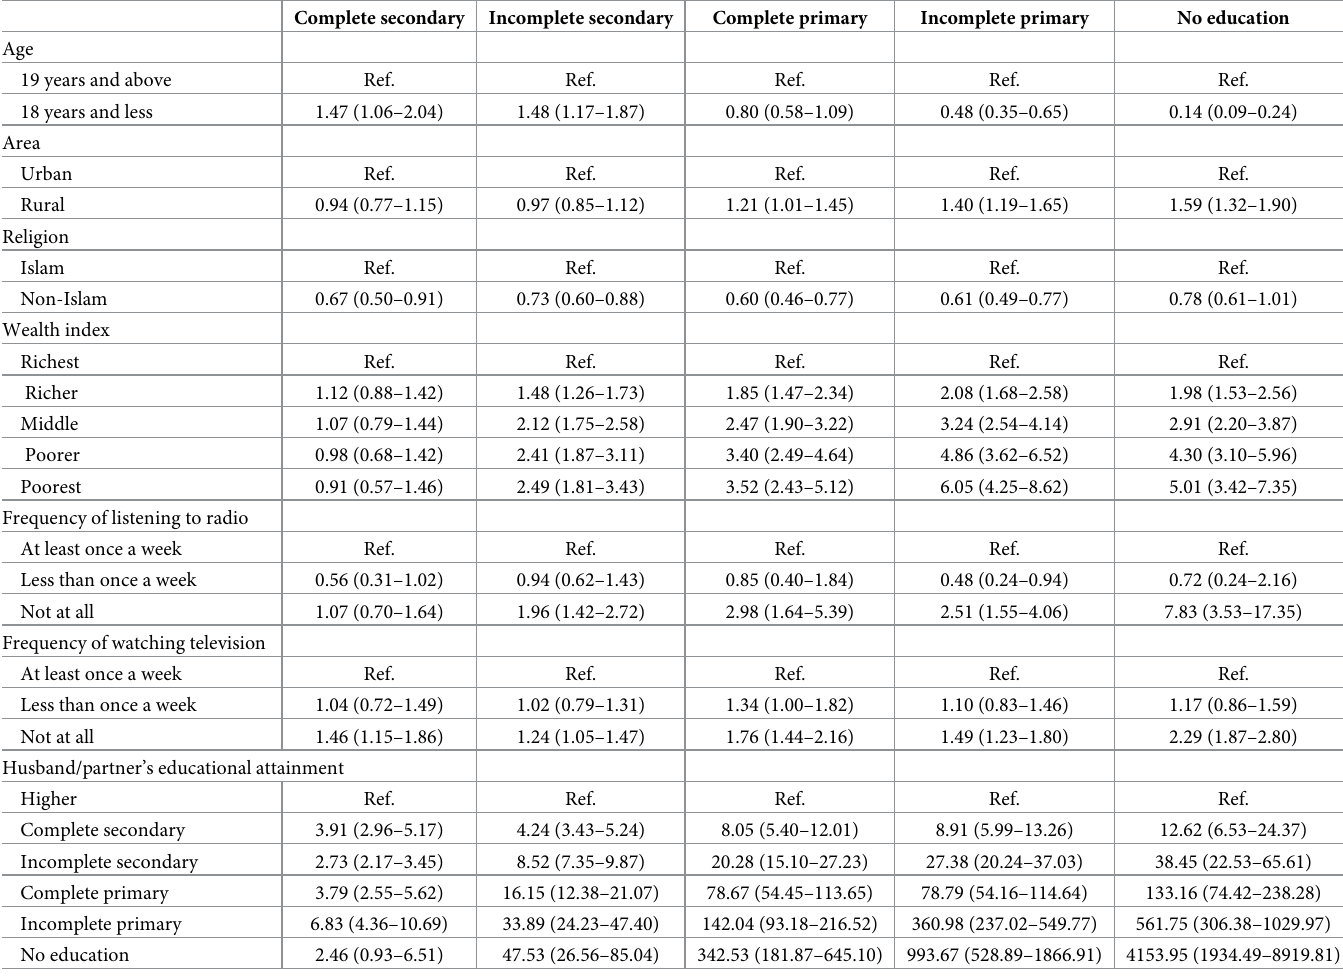
Table 3. Multivariable analysis 1 of maternal education level and different factors in